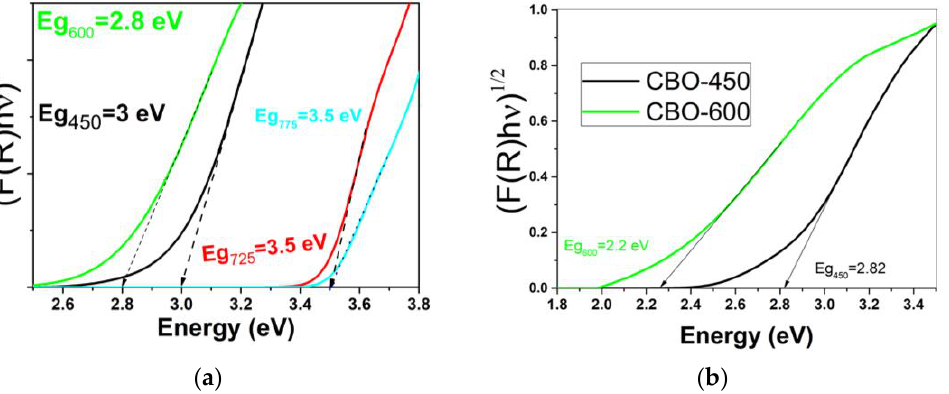
Figure 4. ( a ) The plot of ( α h ν 2 vs. (h ν )) with optical band gaps determination; ( b ) the band gap of CBO-450 and CBO-600.